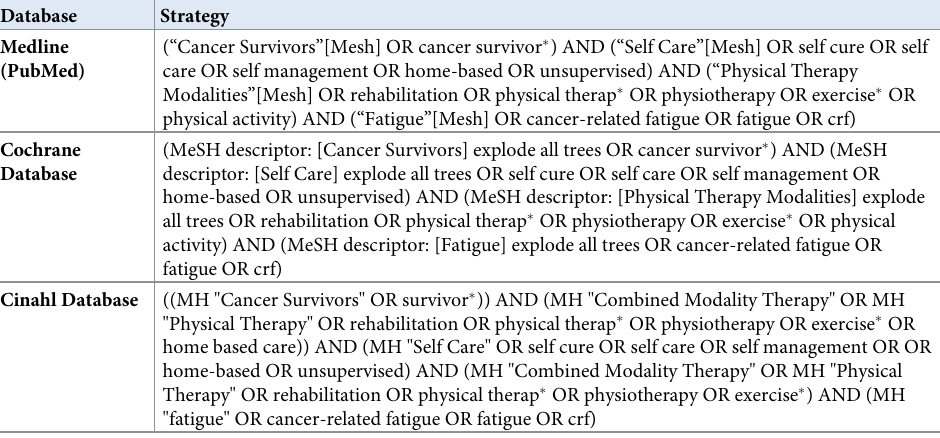
Table 1. Search strategies of the searched